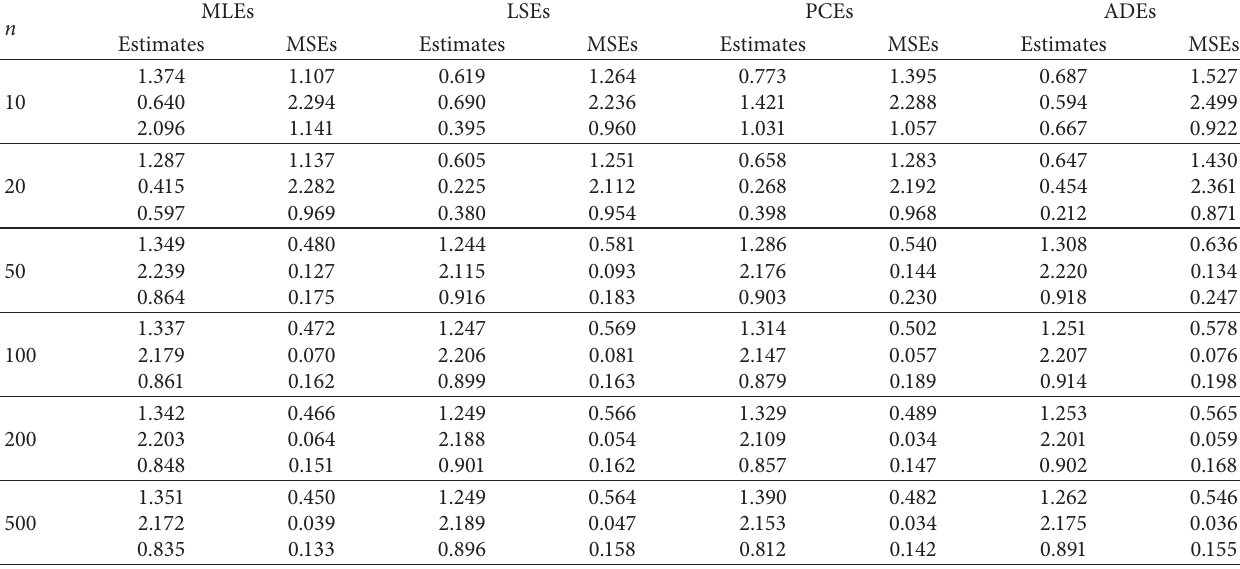
Table 2: Estimates and MSEs of the OFIL distribution for MLEs, LSEs, PCEs, and ADEs for set 1 ( α � 2, θ � 2, and β � 0.5). MLEs LSEs n